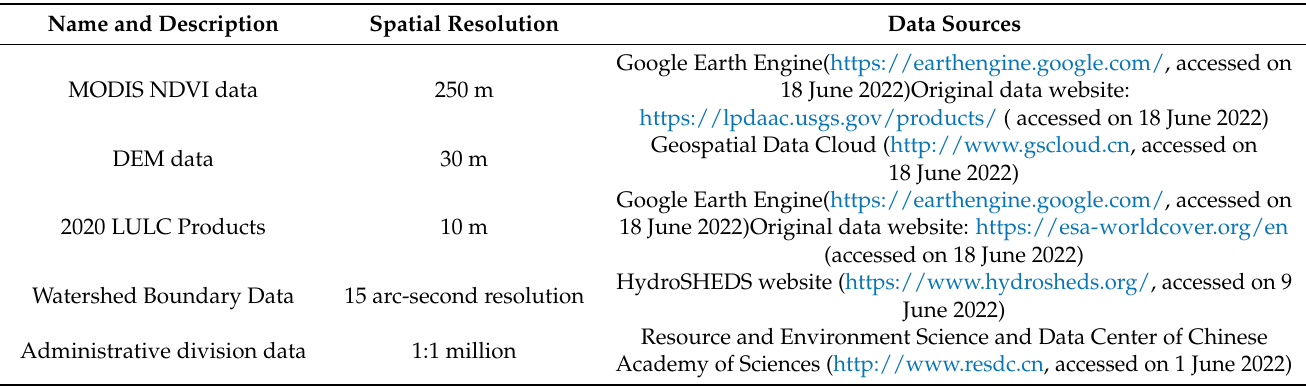
Table 1. Source and description of research